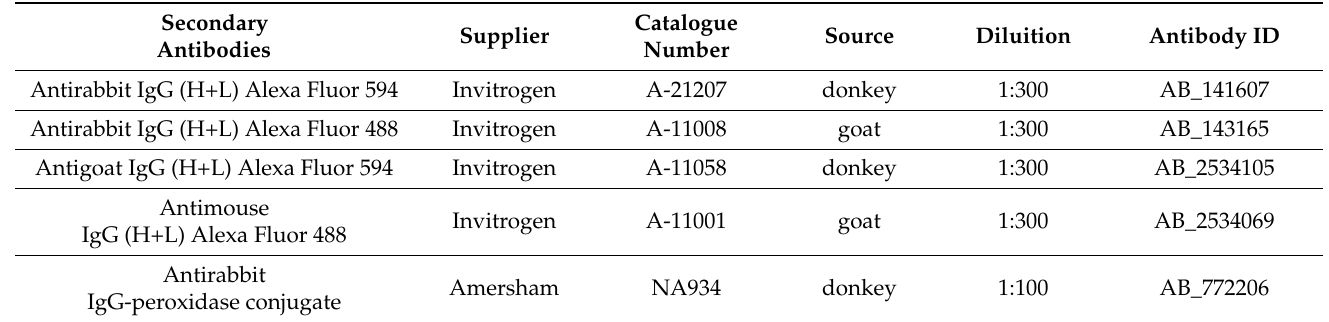
Table 2. Secondary